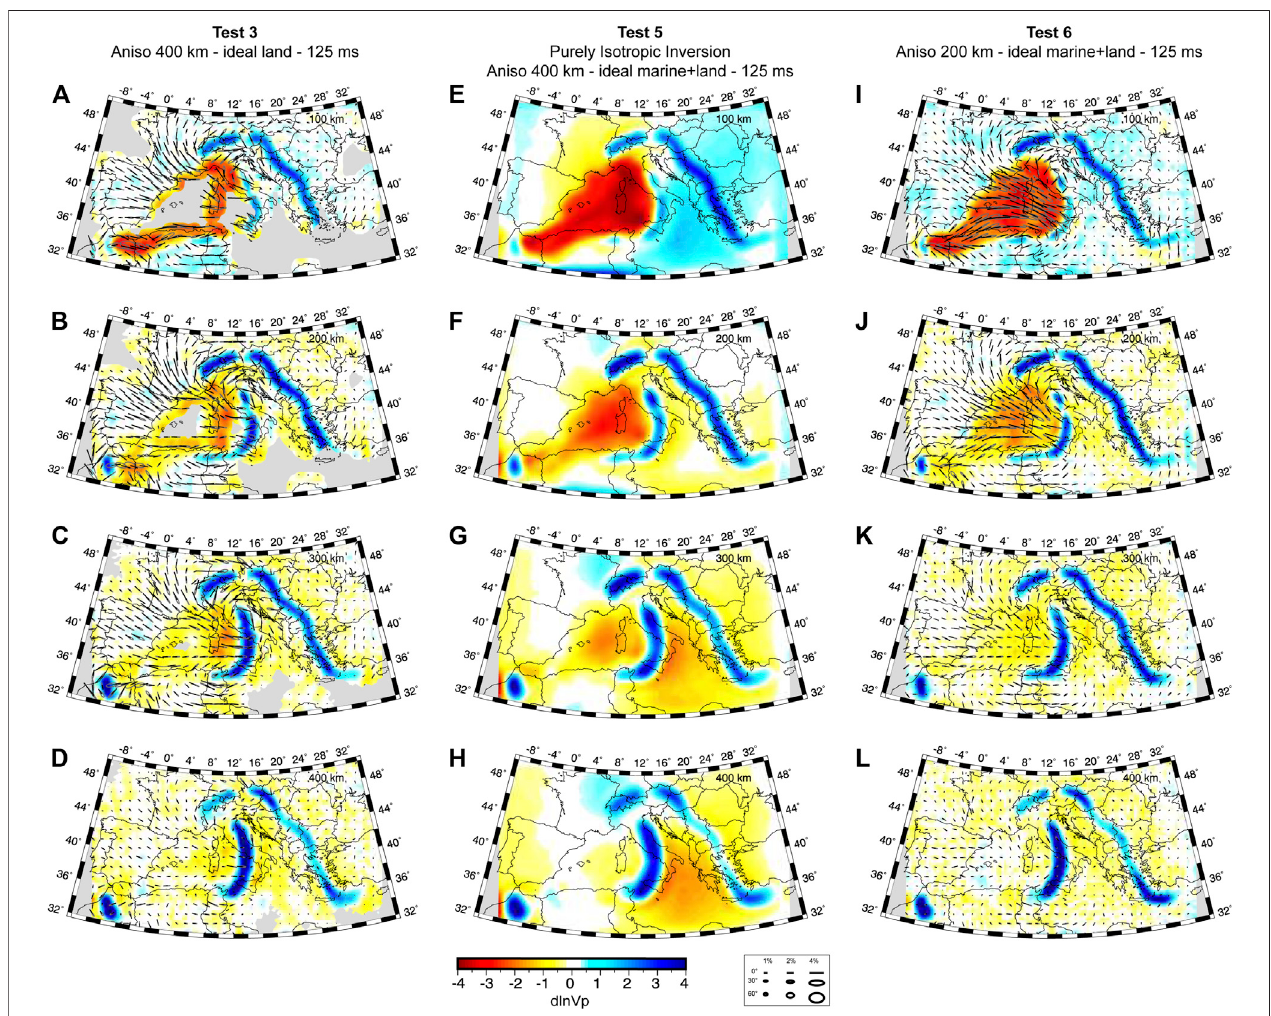
FIGURE 8 | Depth slices at 100 km, 200 km, 300 km and 400 km depth for the tomographic results from Test 3 (A – D) , Test 5 (E – H) and Test 6 (I – L) . Isotropic anomalies are plotted with respect to the starting model. Anisotropy is plotted using ellipses as described in Figure 6 . Areas of poor data coverage are masked in grey.